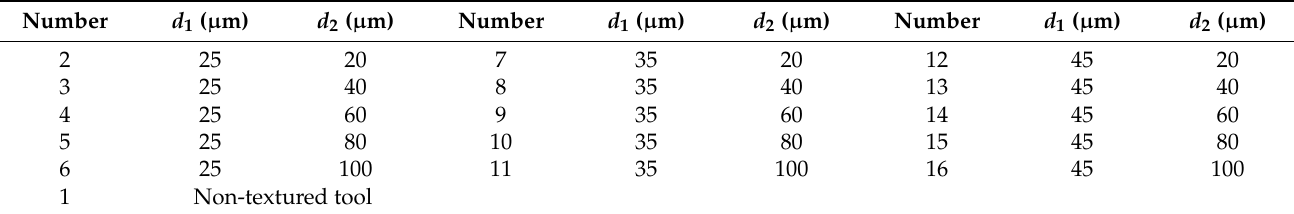
Figure 3. The design of micro-pit texture on PCD tool surface for ( a ) orthogonal cutting and ( b ) micro-turning experiments.